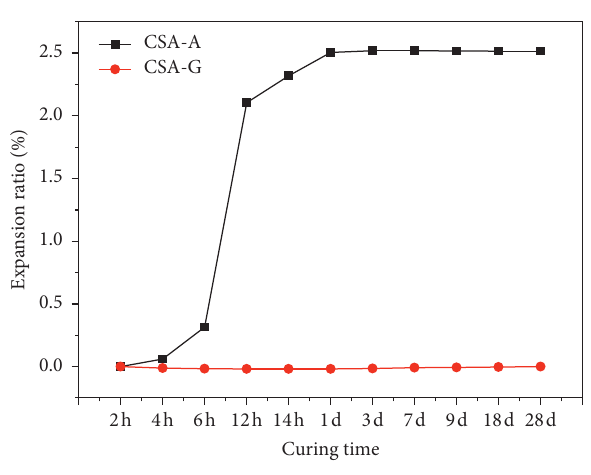
Figure 10: Expansion ratio test